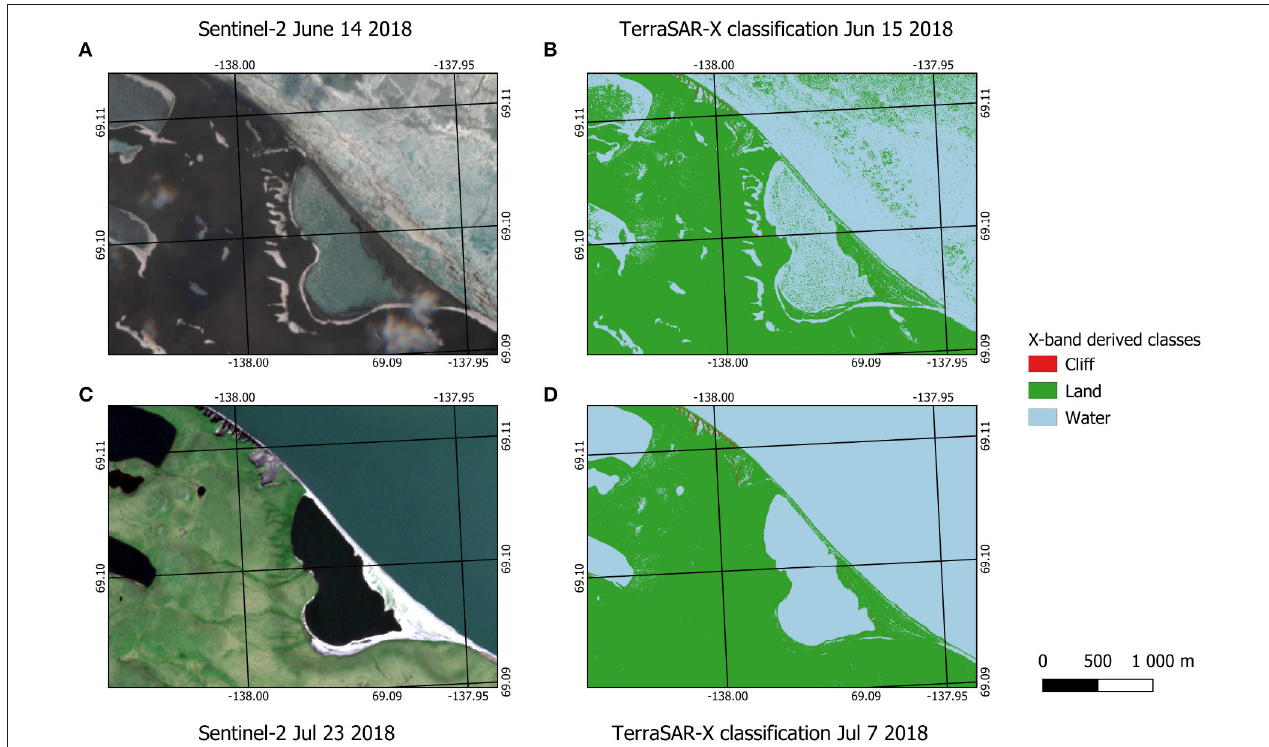
FIGURE 9 | The influence of snow and ice on the classification result of TerraSAR-X at King Point (20 km south of Kay Point). Left (A) and (C) : RGB (band 4, 3, and 2) composites of Sentinel-2; right (B) and (D) : TerraSAR-X derived classes. Snow on land is classified as water (wet snow - low backscatter) and sea ice is partially classified as land (higher backscatter than open water). Sentinel-2 acquisitions represent closest available to TerraSAR-X